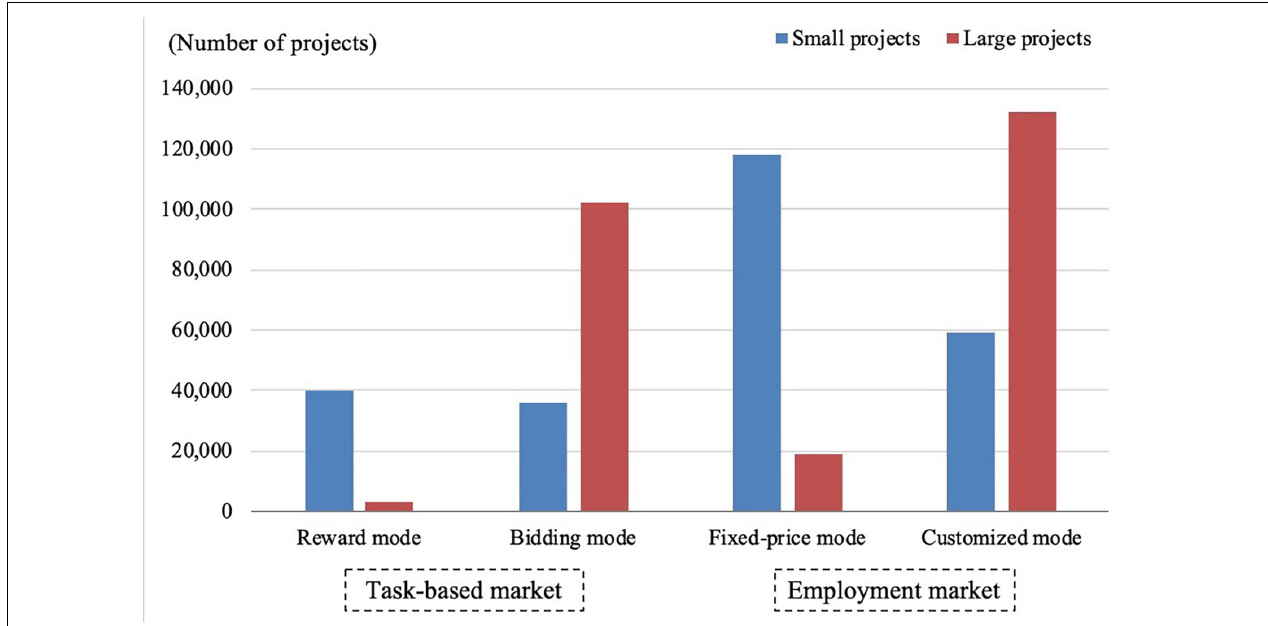
FIGURE 4 | Comparison of project types in which sample vendors participated.